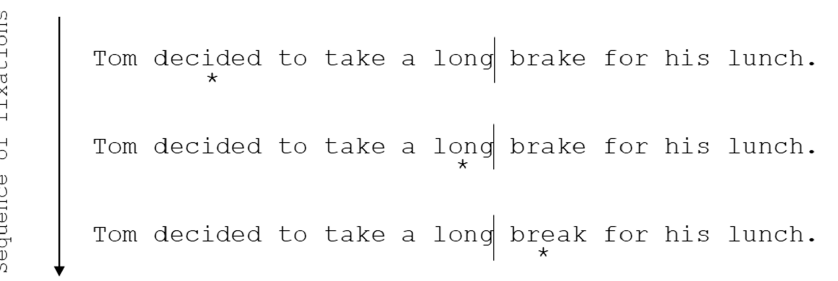
Figure 2. An example of the boundary paradigm. The asterisk underneath each sentence indicates the reader’s fixation location. An invisible boundary is placed in a sentence in the space immediately before a target word (the lines in the example above represent the location of the boundary, but this is not visible to participants). A preview letter string is available in the target word’s location prior to the reader making a saccade that crosses this invisible boundary. After the reader’s eyes cross the boundary, they move to directly fixate the target word. Then, a display change occurs wherein the preview letter string changes to the correct target word. By manipulating certain characteristics of the overlap (e.g., phonological similarity) between the preview string and the target word, parafoveal pre-processing can be studied. For example, phonologically consistent (e.g., brake ) and inconsistent (e.g., bread ) previews can be presented for a target (e.g., break ) to examine the extent to which a reader is undergoing phonological pre-processing prior to direct fixation. If a reader does extract phonological information during parafoveal pre-processing, then reading times on the target word should be shorter following a consistent preview than an inconsistent preview. This decrease to reading times is referred to as preview benefit. If preview benefit is found, i.e., shorter reading times,